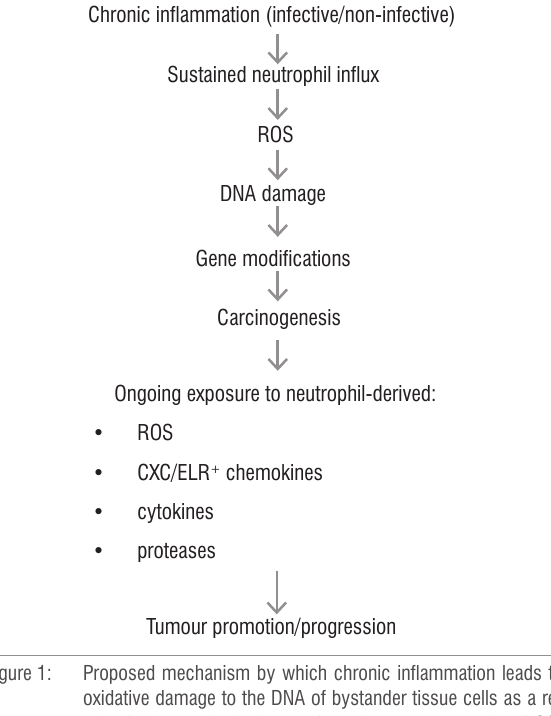
Figure 1: Proposed mechanism by which chronic inflammation leads to oxidative damage to the DNA of bystander tissue cells as a re- sult of the sustained release of reactive oxygen species (ROS) from infiltrating neutrophils. Tumour initiation is followed by promotion and progression as a result of ongoing exposure to neutrophil-derived pro-proliferative and pro-angiogenic media- tors.